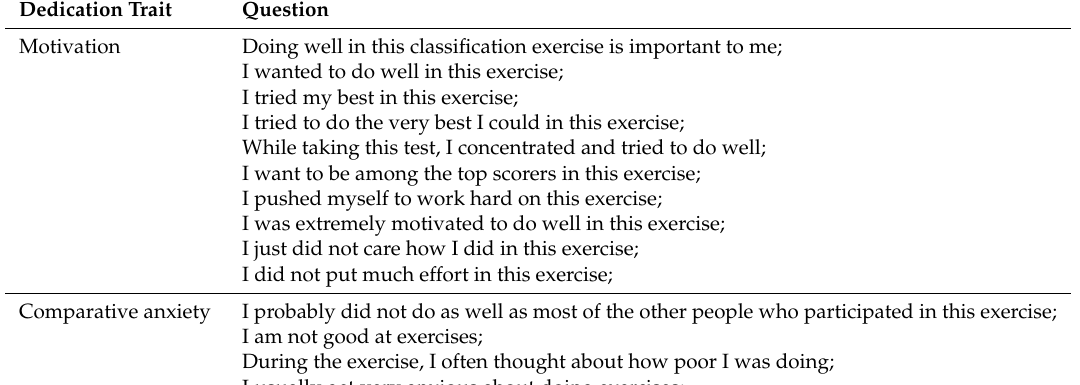
Table 2. Dedication and Personality related questions in the HUMINEX questionaire. Dedication